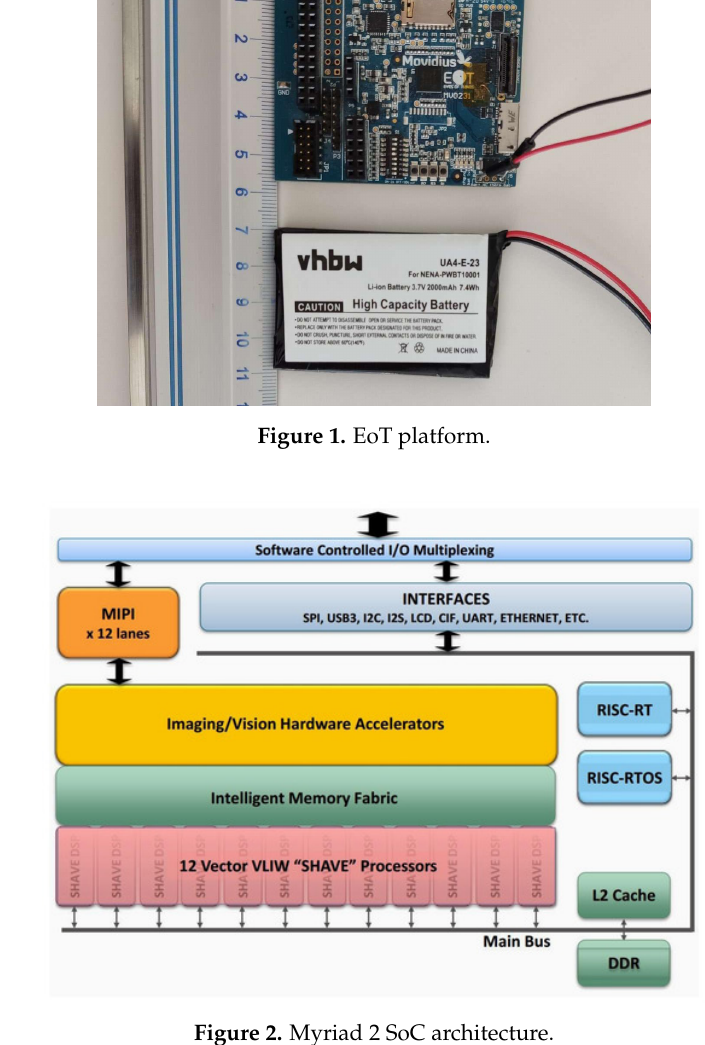
Figure 2. Myriad 2 SoC